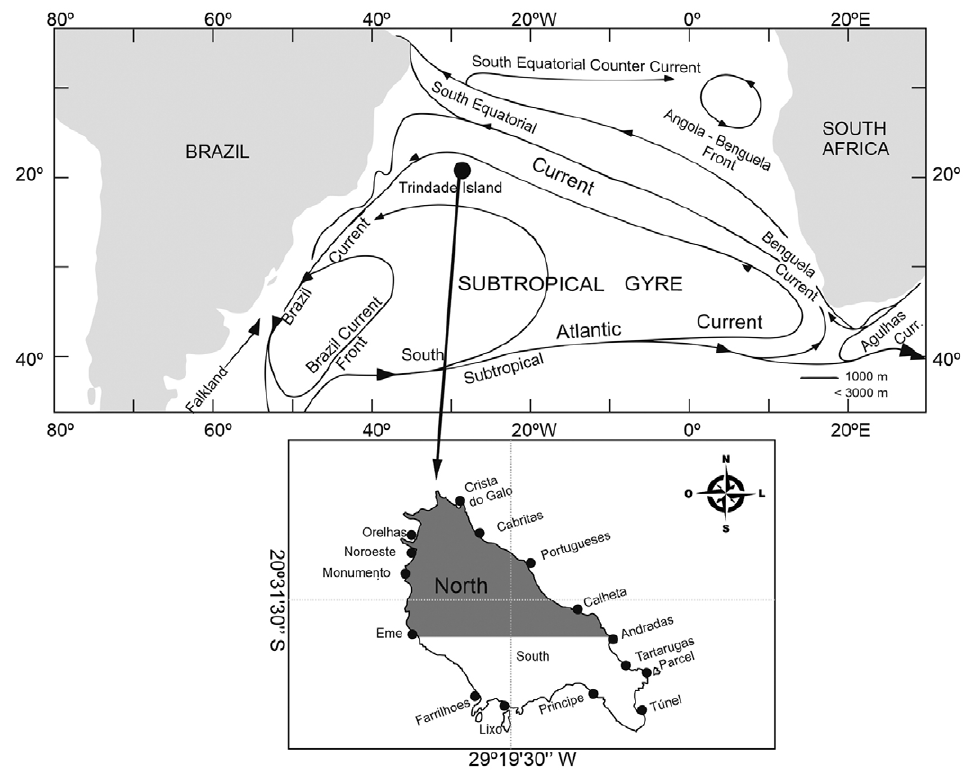
Fig. 1. – Geographic position and oceanic circulation surrounding Trindade, southwestern Atlantic Ocean (adapted from Peterson and Stram- ma 1991). Detailed map from the island